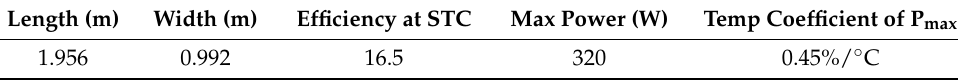
Table 1. Specifications of PV